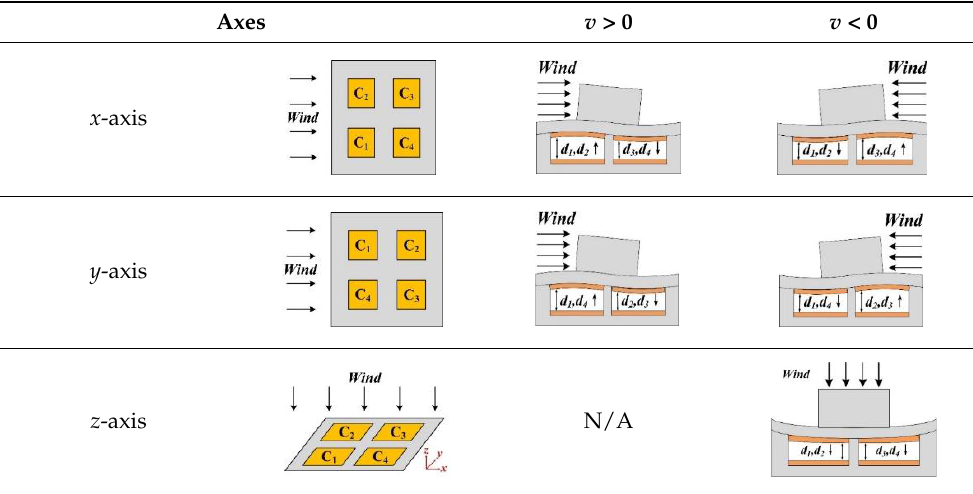
Table 1. Measurement principle along different axes.